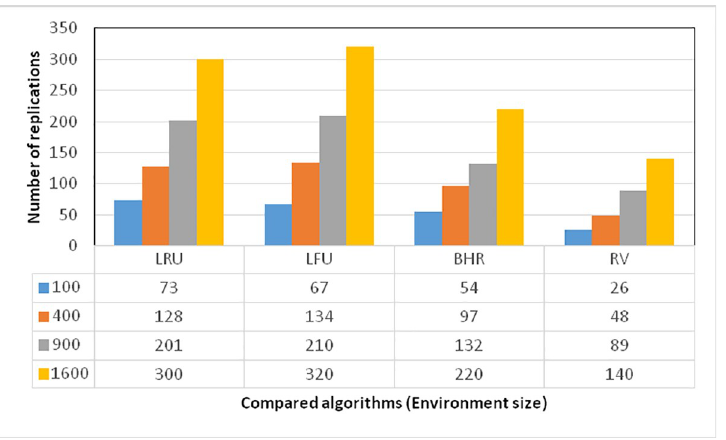
Fig 5. Relationship between the number of replications and replication environment.